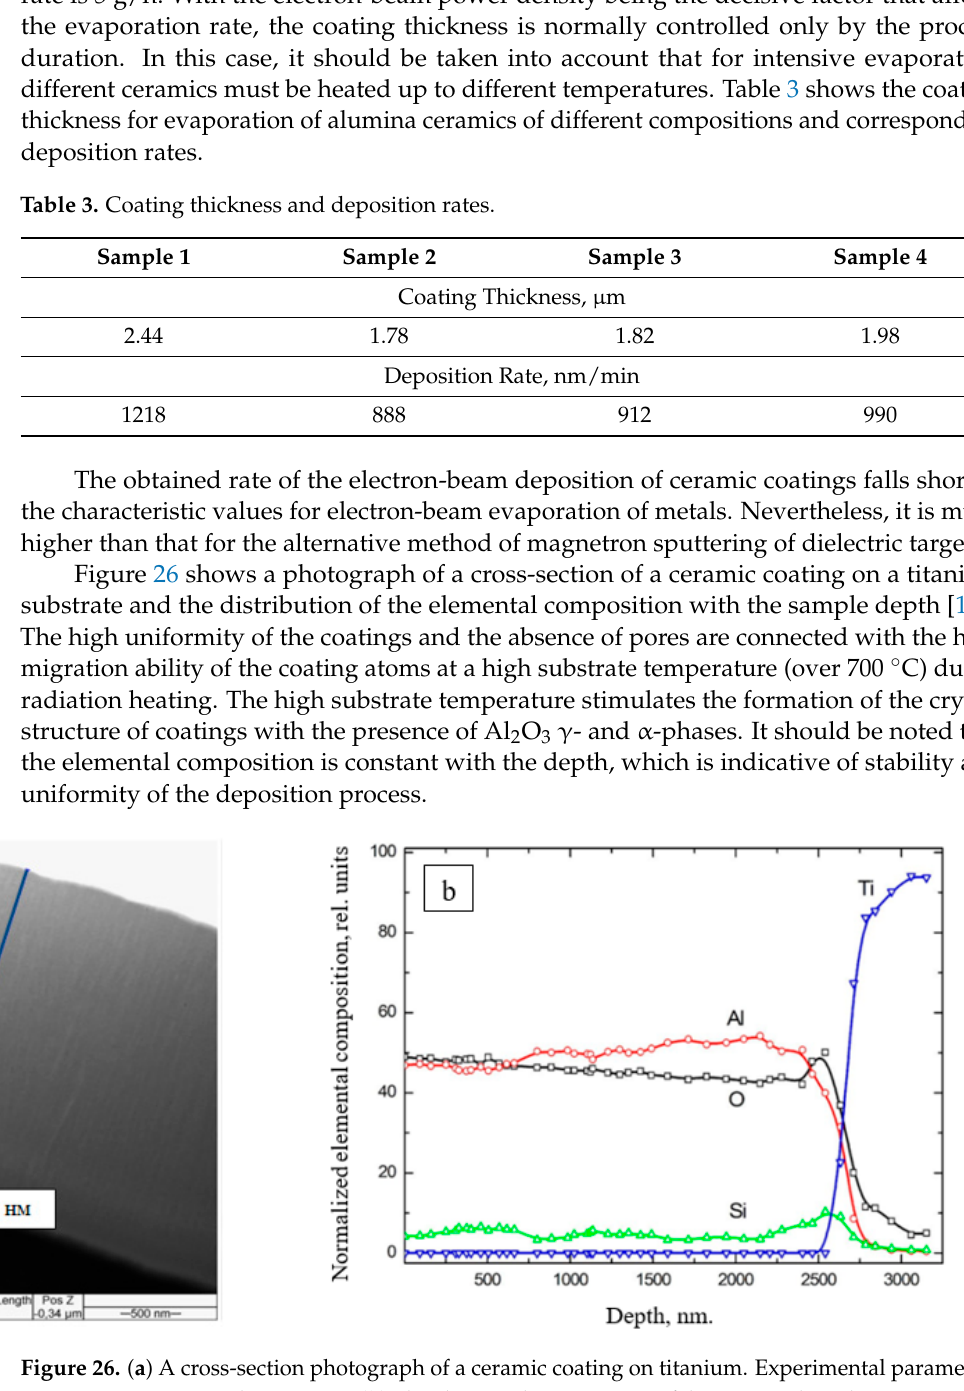
( b ) Figure 27. Surface profile of a ceramic-based coating on titanium: ( a )—original and coated samples; ( b ) — micro-hardness of the original titanium sample and with the deposited Al 2 O 3 coatings of dif- ferent compositions [135]. The maximum micro-hardness amounts to 16 GPa, which almost matches the mi- cro-hardness of aluminum oxide ceramics (Figure 27b). The coatings synthesized from the impurity-free ceramics possess the highest hardness. Such coatings have the most pure elemental composition, with only traces of oxygen and aluminum, and possess a